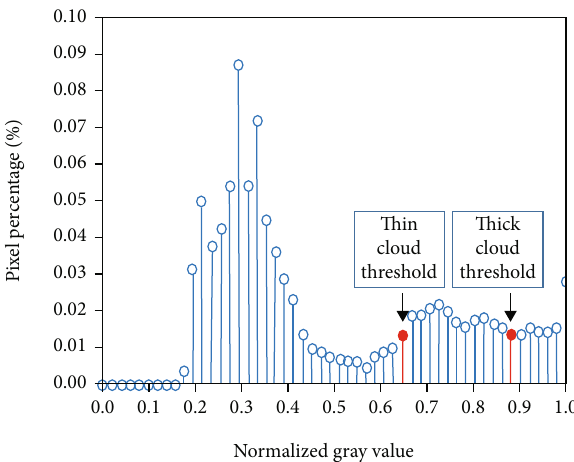
Figure 9: Grayscale distribution of cloud